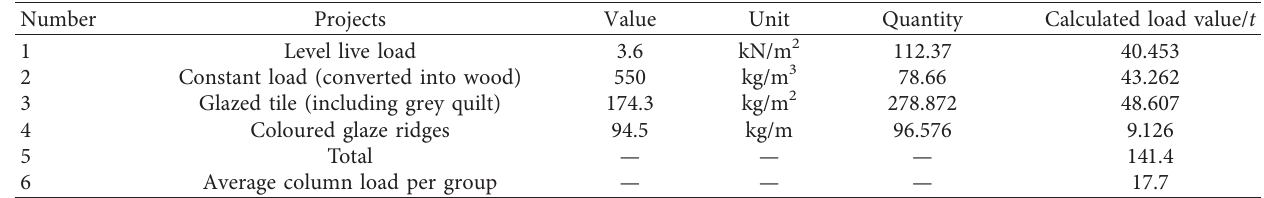
Figure 9: Spatial relationship between Banzai building, Yuanjue Cave, and J10 fissure. Table 2: Banzai building load statistics.